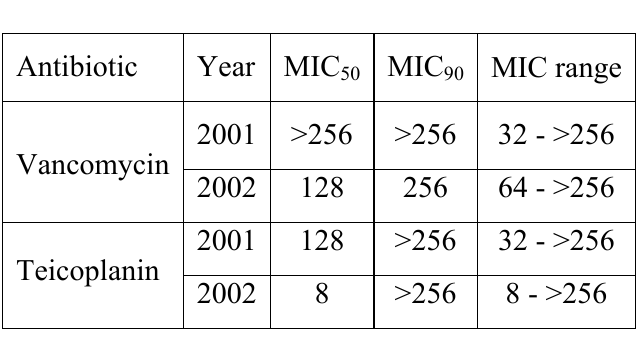
Table 14. MIC and MIC of the vanA positive E. durans isolates (MIC given 50 90